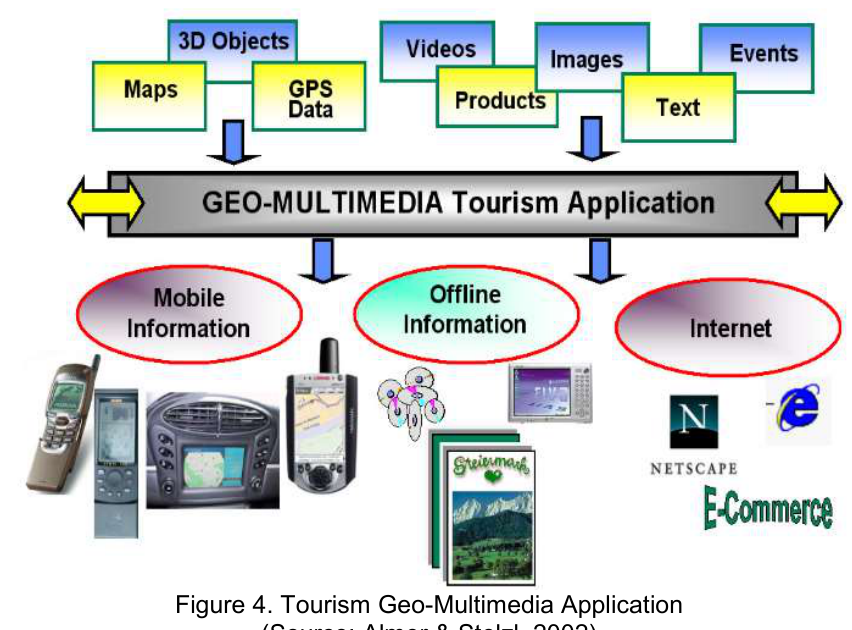
Figure 4. Tourism Geo-Multimedia Application (Source: Almer & Stelzl, 2002)